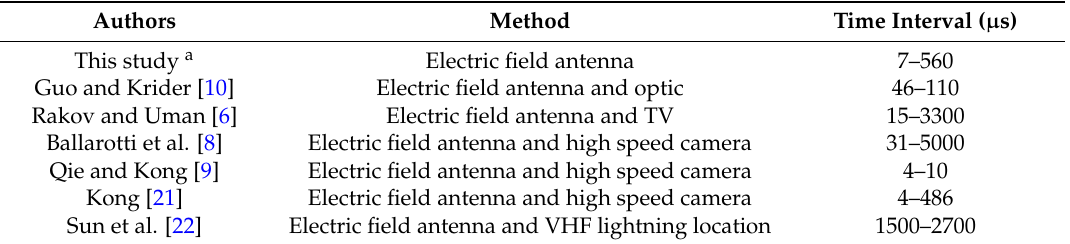
Table 4. The summary of very short time interval of two terminations return stroke.